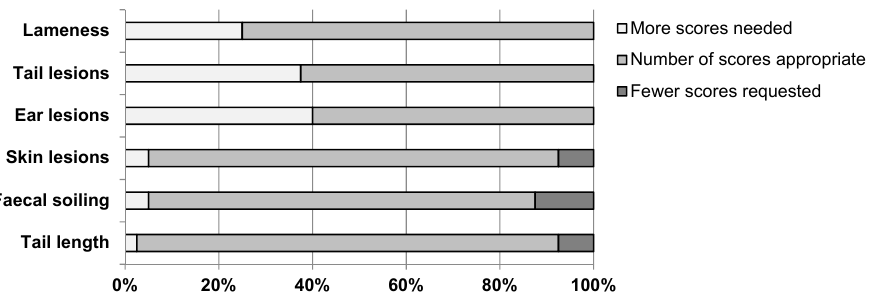
Figure 3. Judgement of 40 fattening pig farmers regarding the number of scores of six KTBL indicators suggested for welfare assessment of fattening pigs (n = 40 judgements per indicator).